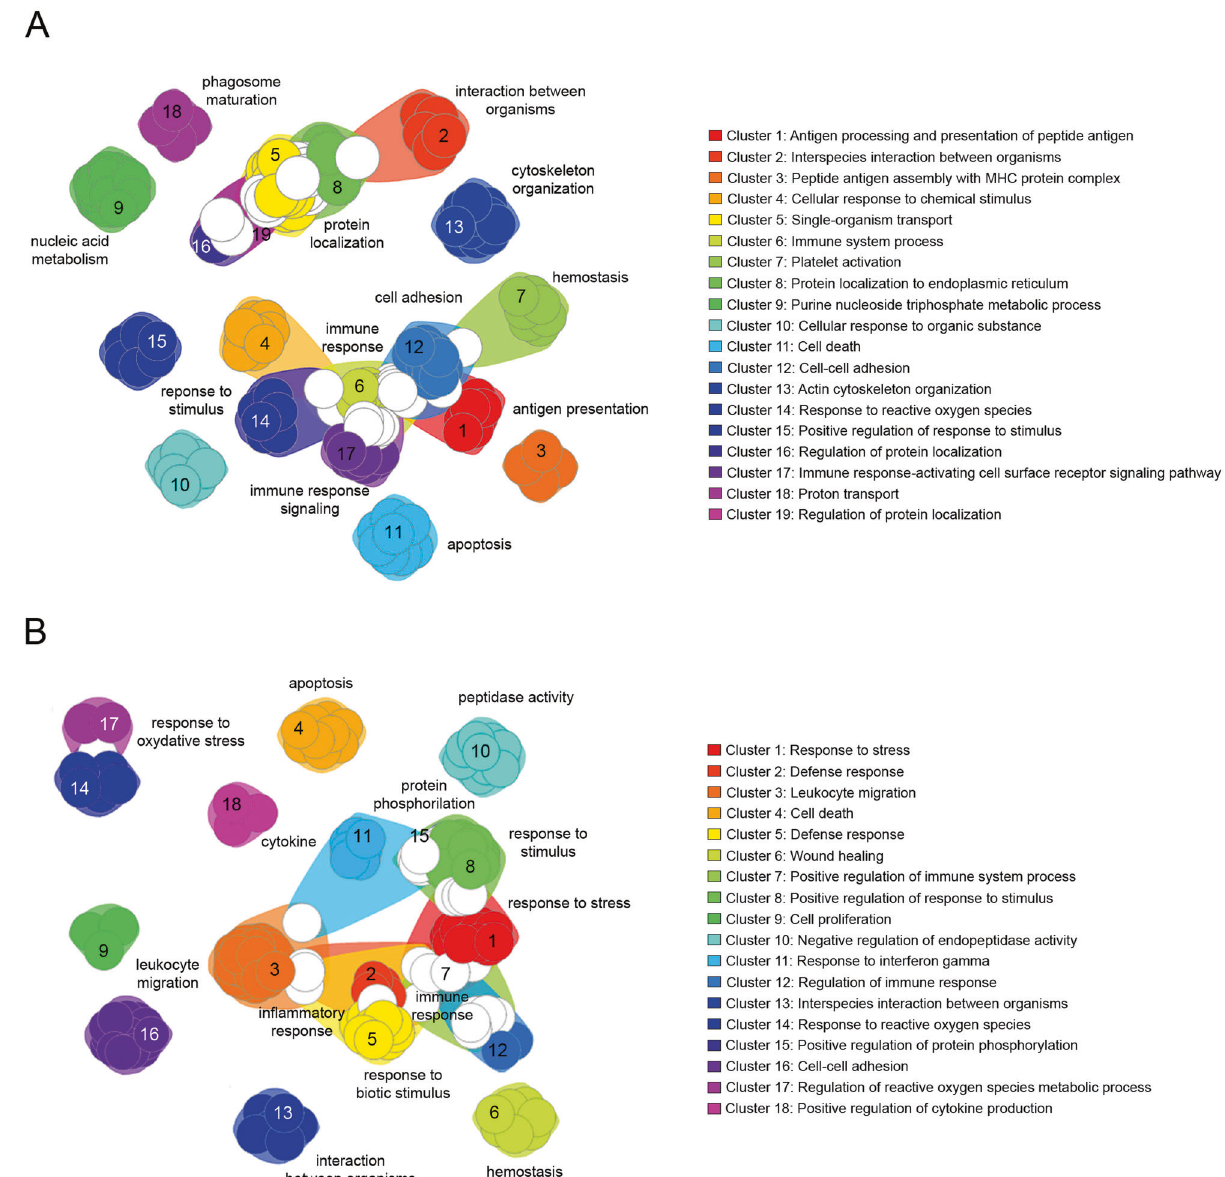
Fig. 3 Gene set enrichment analysis. Functional network with the signi fi cantly enriched clusters of Gene Ontology biological processes (GO) according to DAVID for the genes differentially expressed in untreated monocytes ( A ) and after LPS stimulation ( B ) The network was constructed using FGNet package in R. Each node corresponds to a speci fi c GO term; terms within the same cluster are placed together surrounded by a common background color. Terms that appear in only one functional cluster are plotted with the color of the cluster background whereas terms that are included in more than one cluster are left in white. The clusters are numbered by order of signi fi cant enrichment. The most signi fi cant biological process is indicated for each immune measures in the extended cohort, including the levels of None of the demographic and clinical factors assessed that could Th17 and Treg cells, the levels of circulating monocytes, and the have an impact on gene expression, such as age, gender, disease production of proin fl ammatory cytokines in monocyte cultures severity, use of psychoactive medications or presence of before and after LPS-stimulation ( p < 0.05). In addition, EEF2 and psychiatric comorbidities, showed a signi fi cant association with RHOA expression levels correlated signi fi cantly with the Th17 and the expression levels of the different genes explored. No Treg levels ( p < 0.05). Regarding the LPS-stimulated monocytes, a signi fi cant differences were found either in the gene expression high correlation was observed between the expression levels of levels between patients and controls (results not shown). the nine genes analyzed ( ALDOA , CCL3 , CXCL1 , CXCL8 , ENO1 , However, a signi fi cant correlation was observed between the FCGR2A , IL1B , MSN and TXN ) and the circulating monocyte levels gene expression of the monocyte samples in both conditions and as well as between the gene expression levels and the production some of the immune parameters previously assessed in these of granulocyte-macrophage colony-stimulating factor (GM-CSF) by individuals (Fig. 4). Speci fi cally, four genes differentially expressed LPS-stimulated monocytes ( p < 0.05). In addition, the expression in the microarray data under basal conditions ( HLA-DRA , HLA- levels of most genes ( CCL3 , CXCL1 , CXCL8 , IL1B , MSN , and TXN ) DRB1 , IFI30 and PABPC1 ) were highly correlated with different